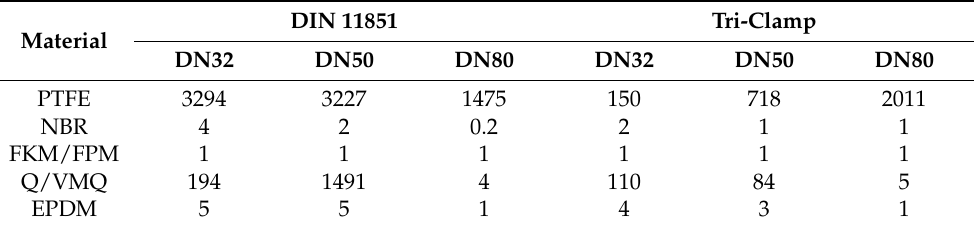
Table 9. Comparison of the OTR levels of the different seal materials in relation to the FKM/FPM in the two types of connectors and for each of the diameters